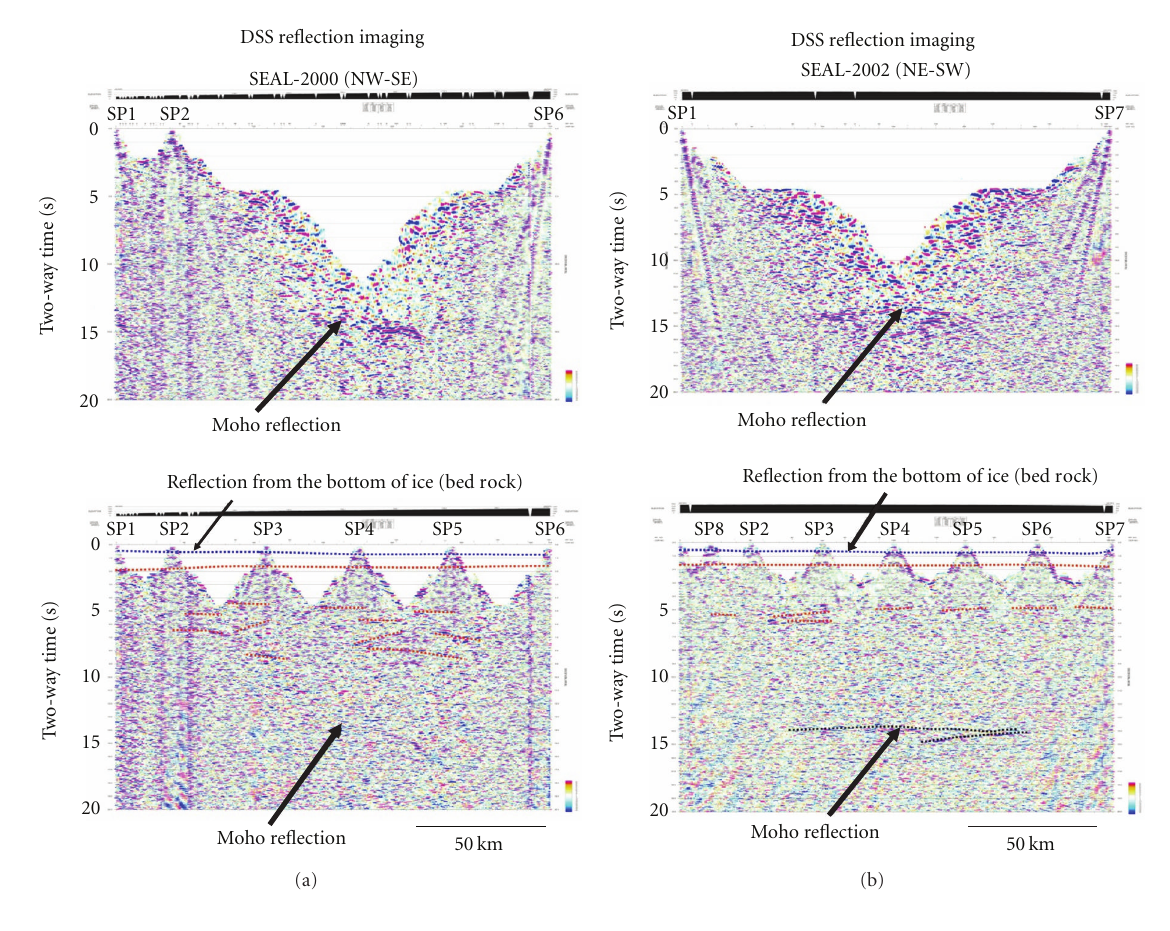
Figure 12: (a) (upper) Single-fold CDP section showing far o ff set shots for SP 1, SP 2, and SP 6 of the SEAL-2000 profile. The Moho reflections are indicated by black solid arrow. (lower) CDP stack section o ff set linked to near traces for the SEAL-2000 profile. Several reflections in the crust and the Moho are identified by red broken lines and black solid arrows, respectively. In addition, reflections from the bottom of the ice sheet are traced by the light-blue broken line. All the figures are after Kanao et al. [17]. (b) (upper) Single-fold CDP section showing far o ff set shots for SP 1 and SP 7 of the SEAL-2002 profile. The Moho reflections are indicated by black solid arrows. (lower) CDP stack section with o ff set limited to traces within 120km for the SEAL-2002 profile. Several reflections in the crust and the Moho are identified by red- and black-colored broken lines. In addition, reflections from the bottom of the ice sheet are traced by the light-blue broken line. All the figures are after Kanao et al.